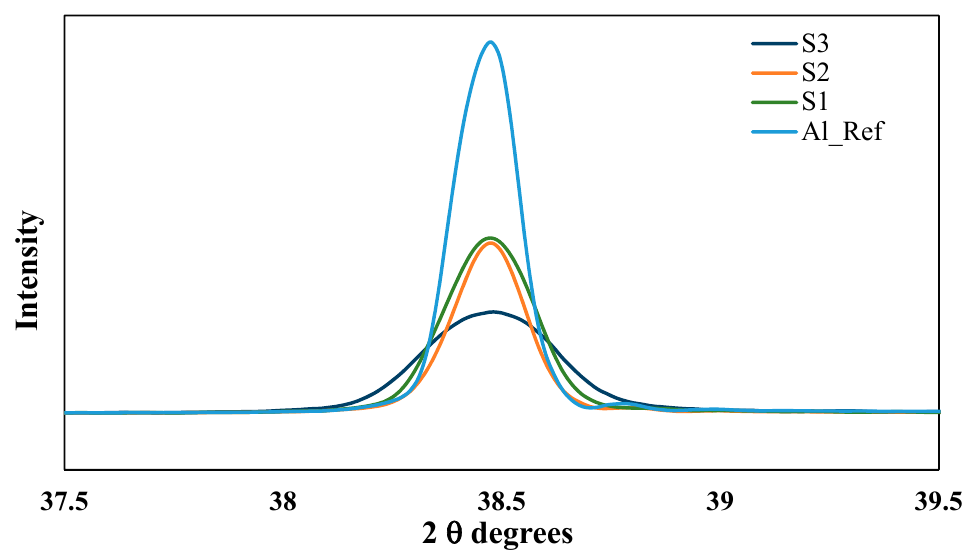
Figure 6. Magnified first Al peaks for the bulk composites.